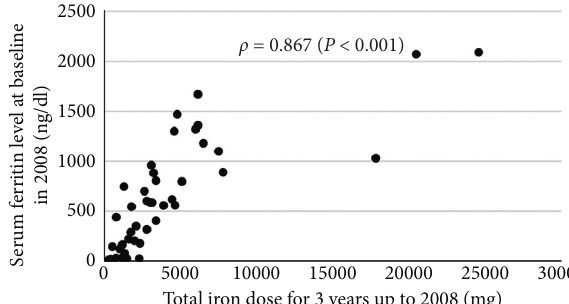
Figure 2: Relation between total iron dose injected in three years and serum ferritin level. ρ , Spearman’s rank correlation coefficient.